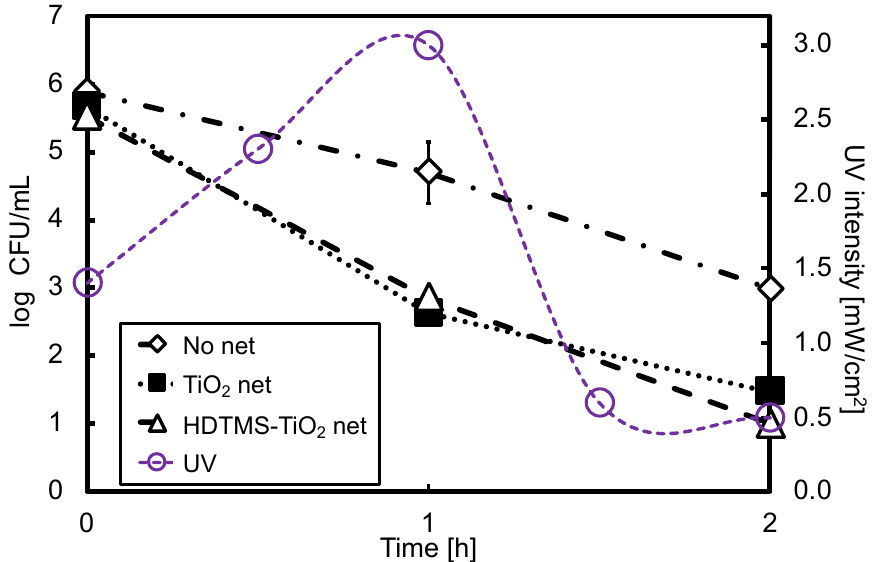
Figure 11. Photocatalytic sterilization (logarithmic reduction) of E. coli using the TiO 2 net and the HDTMS-TiO 2 net under natural sunlight.